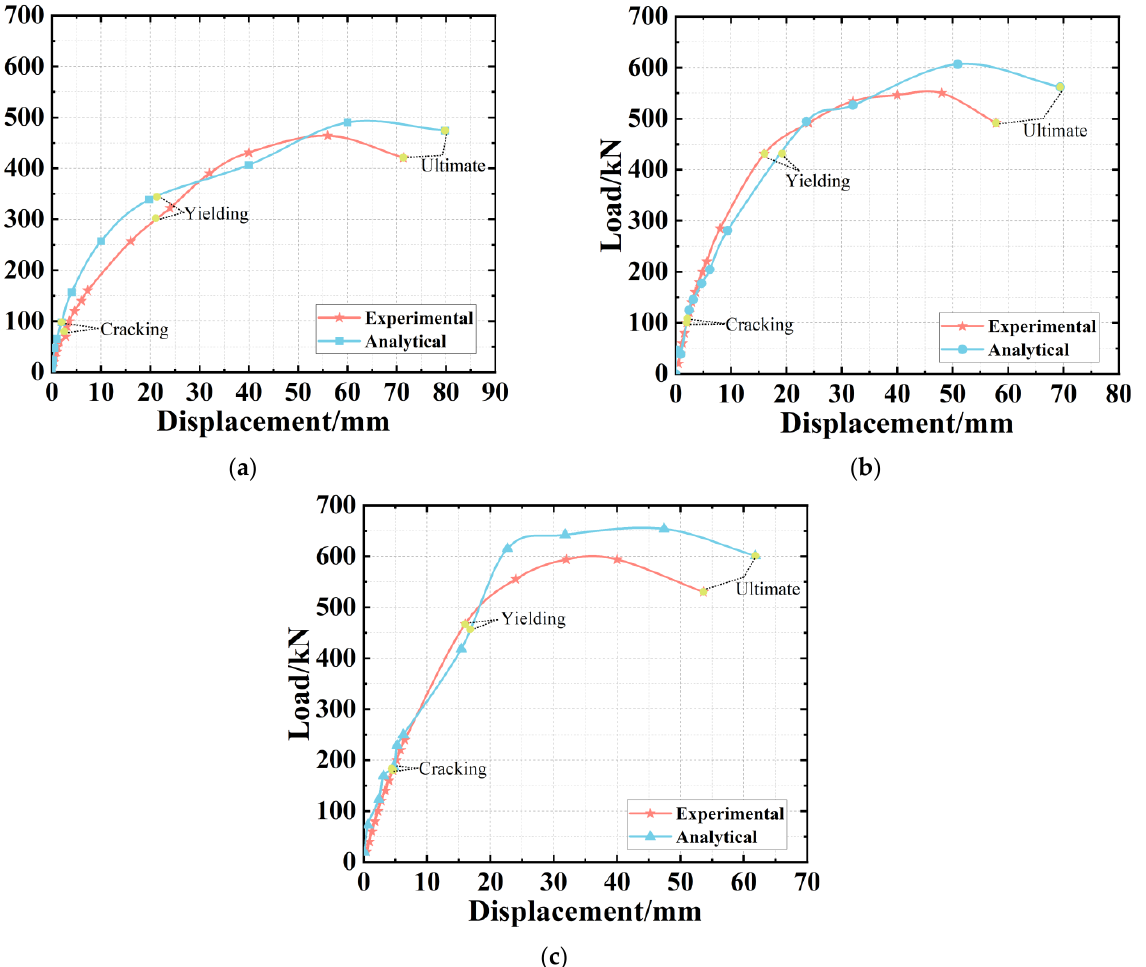
Figure 14. The Comparative Results of Experimental and Analytical Load – Displacement